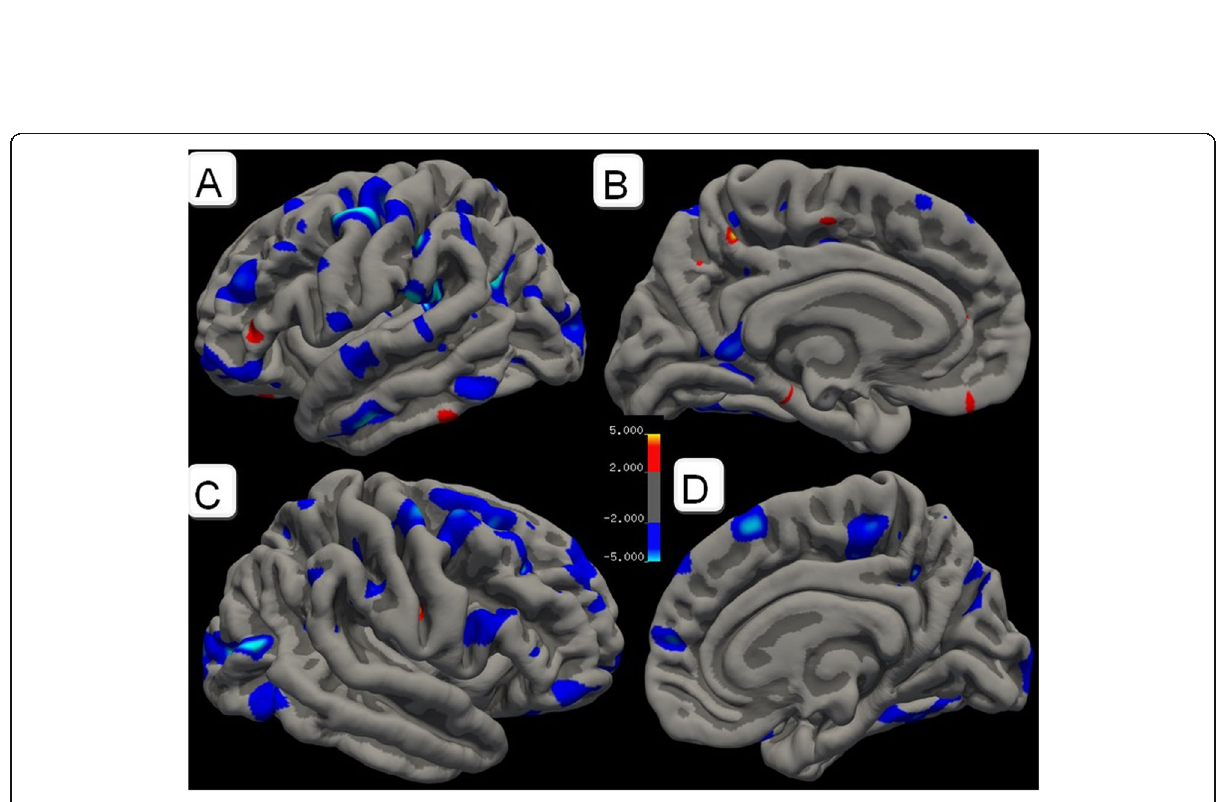
Fig. 4 Brain surface demonstrating significant differences between youth with conduct disorder (CD only) versus those with conduct disorder comorbid with attention deficit-hyperactivity disorder (CD + ADHD). a Left lateral. b Left medial. c Right lateral. d right